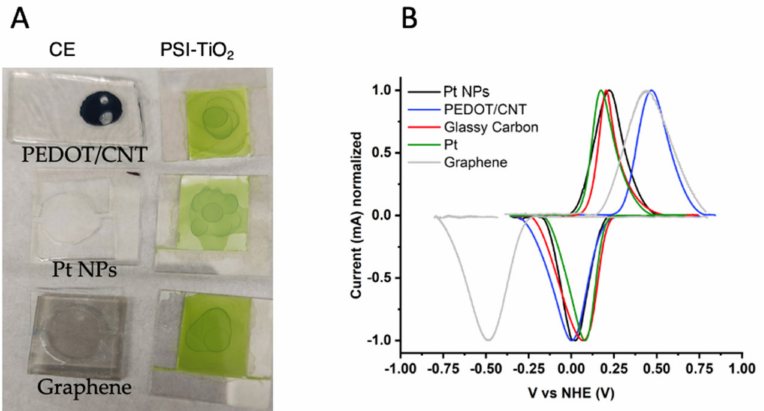
Figure 4. Counter electrode characterization. ( A ) Photograph of the three PSI-SSC with different counter electrodes (left) and PSI-sensitized TiO 2 photoanodes (right) on FTO glass. ( B ) Cyclic voltammograms of the of aqueous-soluble bipyridine cobalt (II/III) redox mediator using different working electrodes. All voltammograms were measured at 100 mV/s, baseline corrected, and current was normalized to account for variation in working electrode surface area. Pt wire and a saturated calomel electrode were used in all measurements as the counter and reference electrodes,